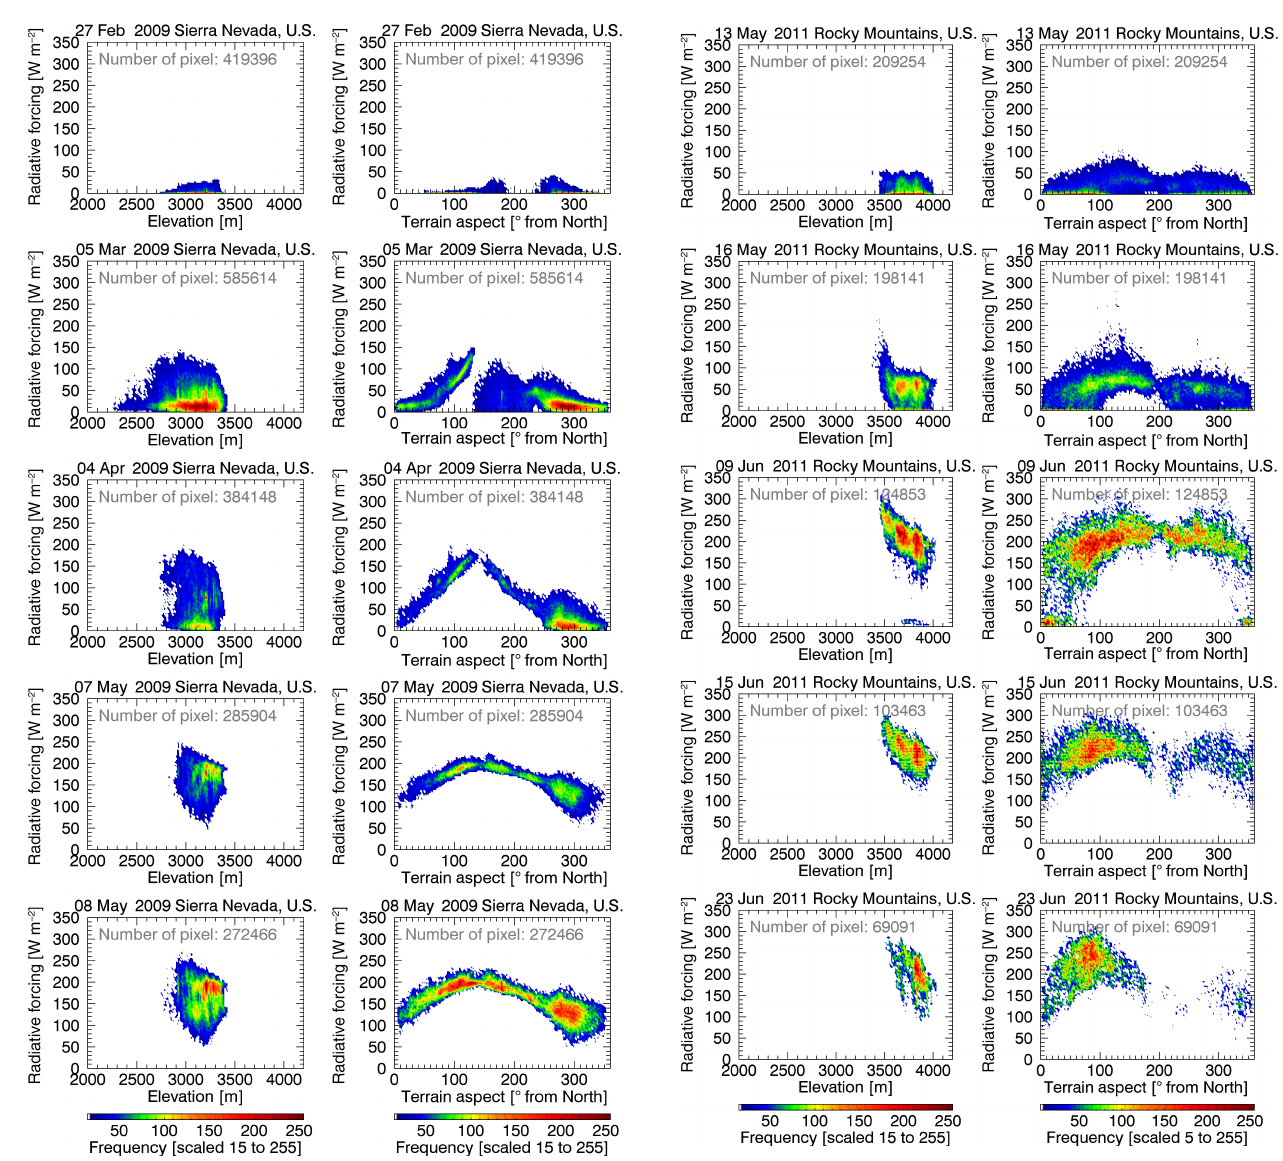
Figure 14. Radiative forcing of snow impurities with respect to ter- rain elevation (left panels) and aspect (right panels) in the Sierra Nevada in spring 2009.